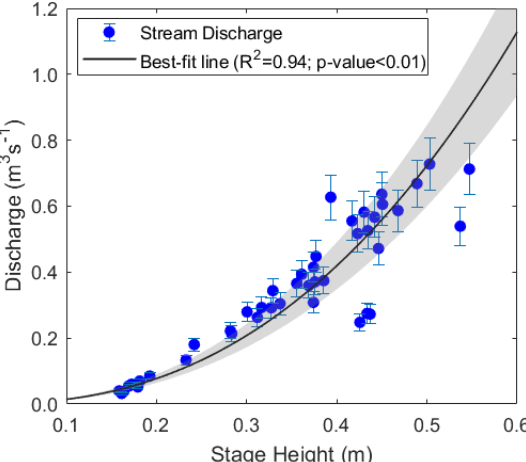
Figure 4. Rating curve (black line) determined from the best fit of the power law (Eq. 1) to 5min continuous measurements of stage corresponding to discrete measurements of discharge (blue dots). Error bars show measurement error uncertainty ( U me ). Rating curve uncertainty ( U RC ) is shown in the grey-shaded area at the 95%CI (see Appendix A for uncertainty